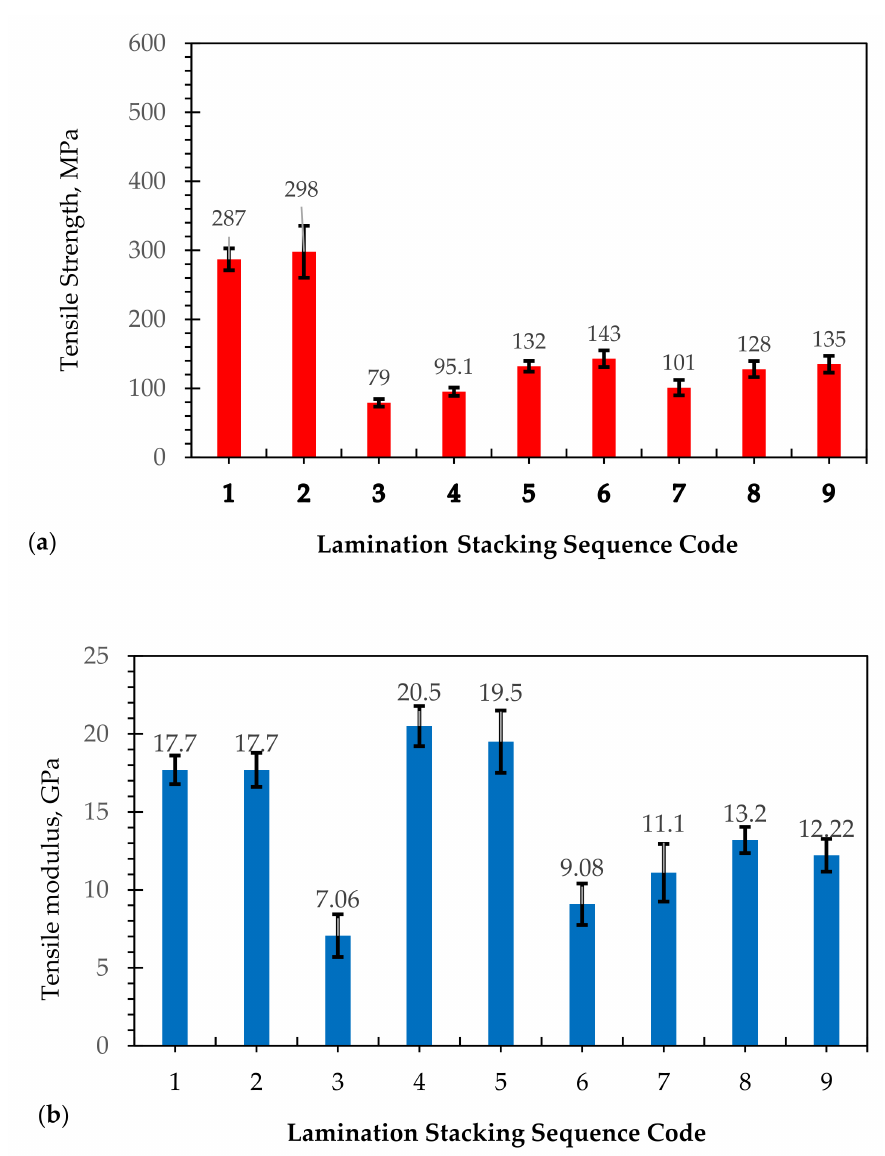
Figure 1. ( a ) Tensile strength and ( b ) modulus of elasticity of different lamination stacking sequences of hybridization of abaca/glass fiber fabricated by VARTM. Note: The numbers 1-9 pertain to lamination stacking sequence code (see Table